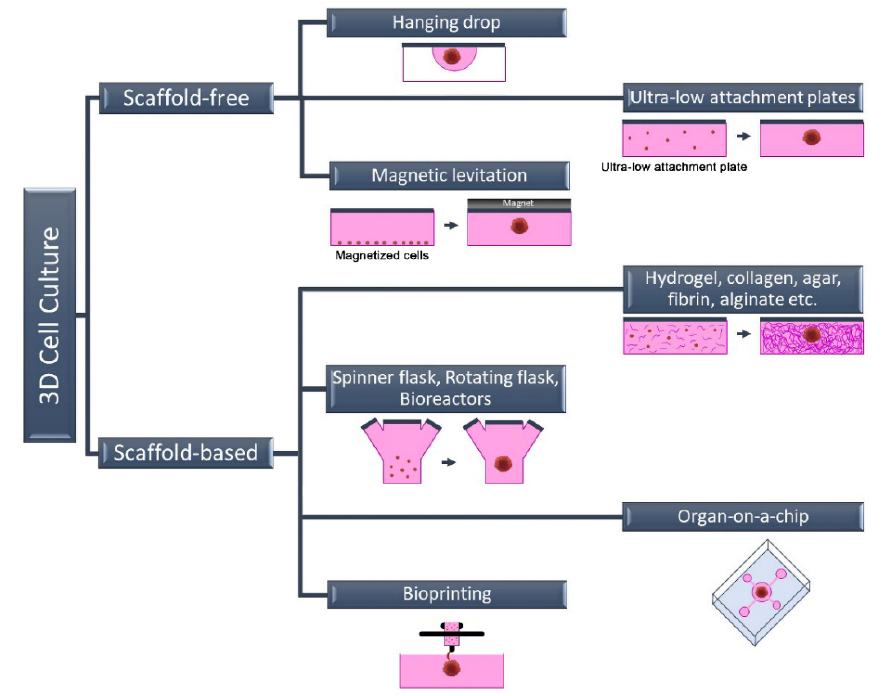
Figure 1. Schematic representation of three ‐ dimensional cell culture methods . 75